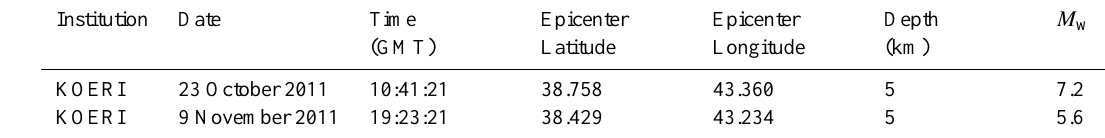
Table 1. 23 October and 9 November 2011 Van Earthquakes’ seismological parameters reported by KOERI (2011).